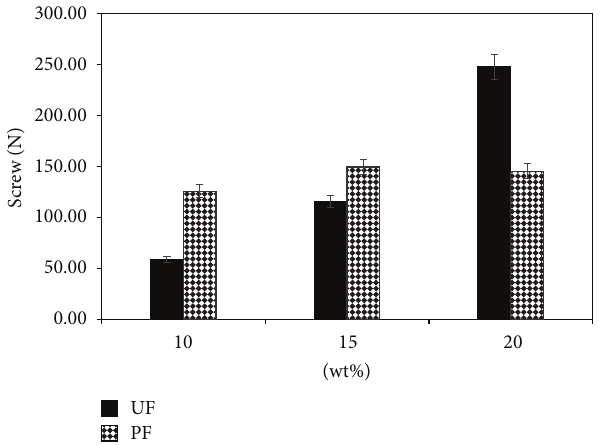
Figure 5: Screw test of sago particleboard versus resin matrix content (wt%).